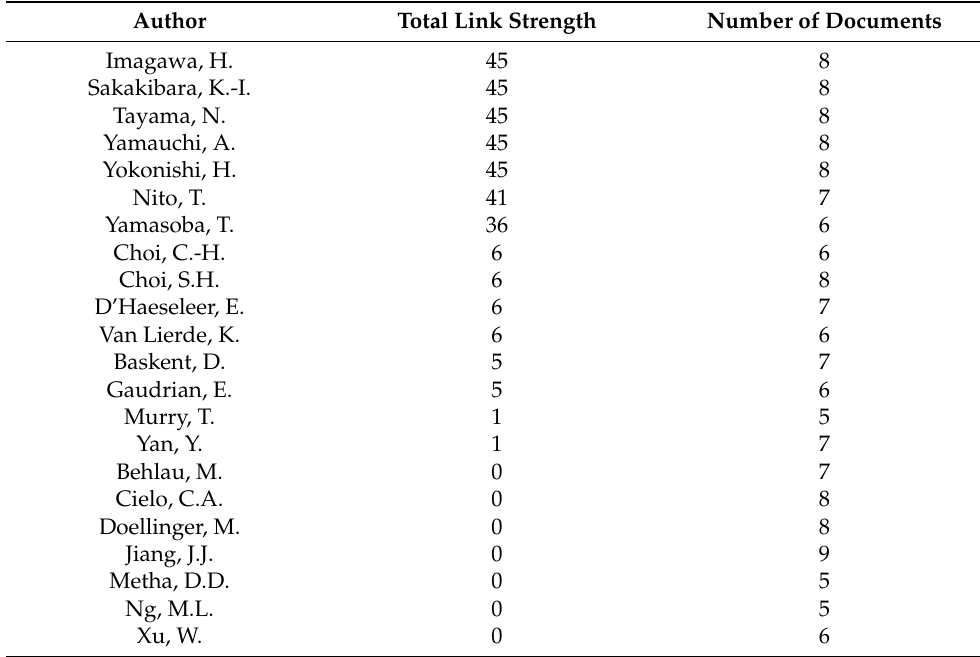
Table 1. Authors in order of highest to lowest Total Link